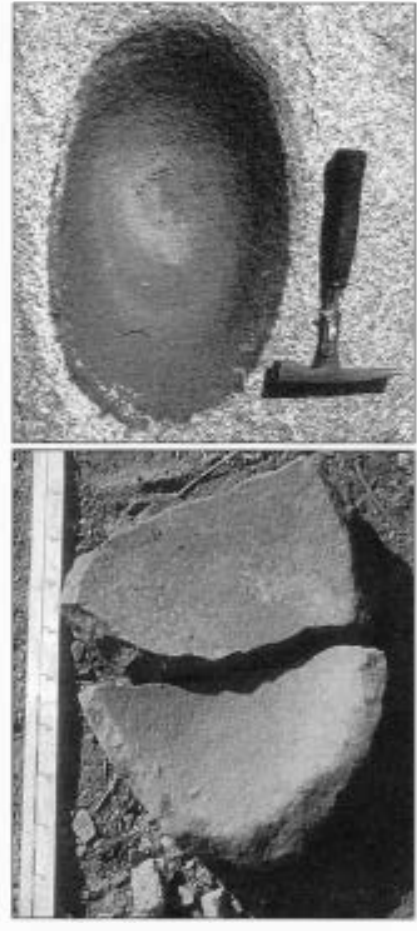
Figure 6 Elliptical hollow in granite boulder (above, with geological hammer for scale) and broken grindstone (below, with 50 cm scale) used for grinding or pounding seed foods at the hiJltop settle­ ment of Sanganakallu.